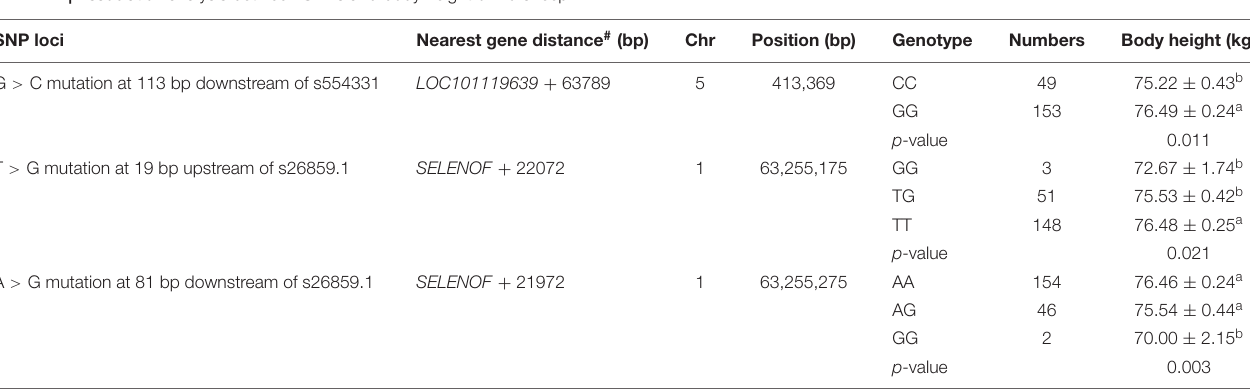
TABLE 2 | Association analysis between SNPs and body height of Hu sheep. SNP loci Nearest gene distance # (bp) Chr Position (bp) Genotype Numbers Body height (kg) G > C mutation at 113 bp downstream of s554331 LOC101119639 + 63789